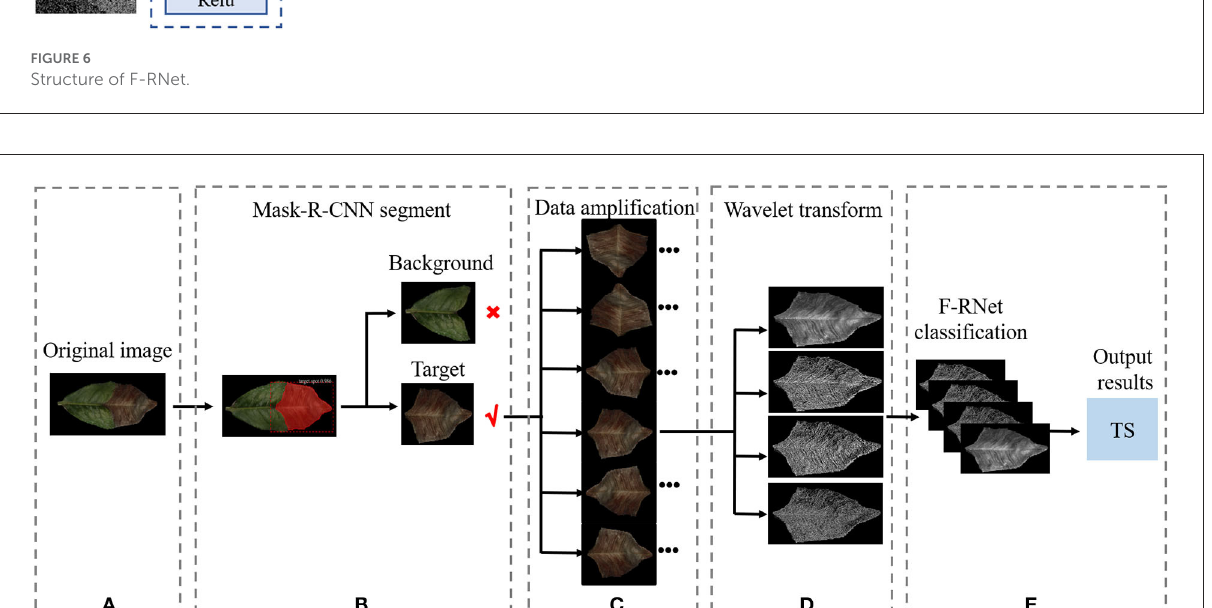
FIGURE7 A legend to summarize the overall framework of this study. (A) Original image; (B) Mask R-CNN segment; (C) Amplification; (D) Wavelet transform; (E) F-RNet